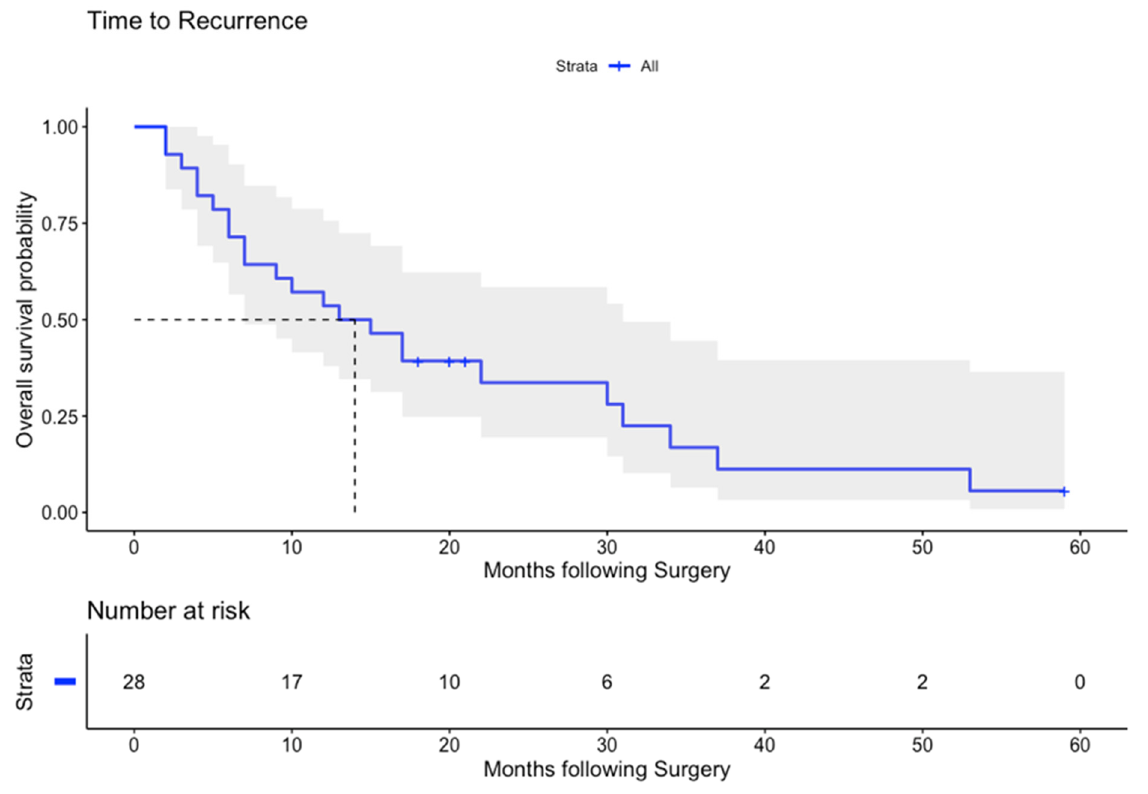
Figure 1. Kaplan–Meier curve for disease-free survival. Data show time to recurrence in months. Shaded blue area shows 95% CI. Number at risk at each timepoint provided.